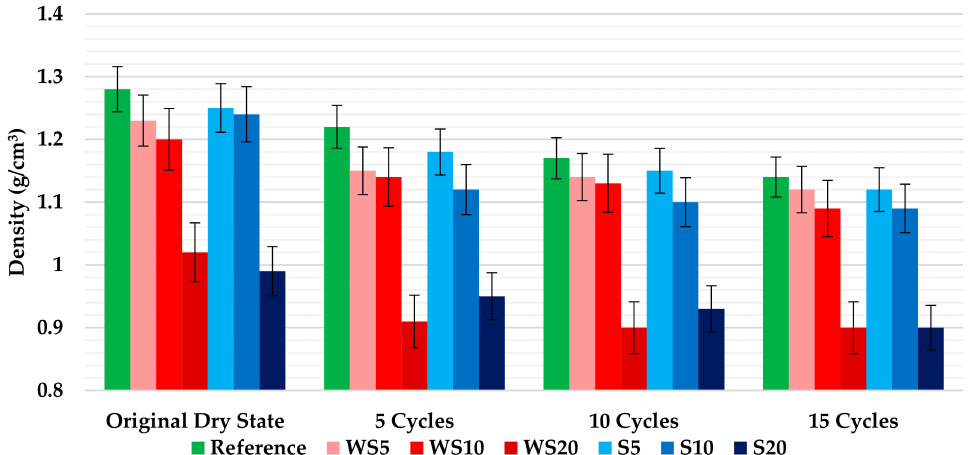
Figure 8. Density of the plasters after 0, 5, 10, and 15 wetting–drying cycles.